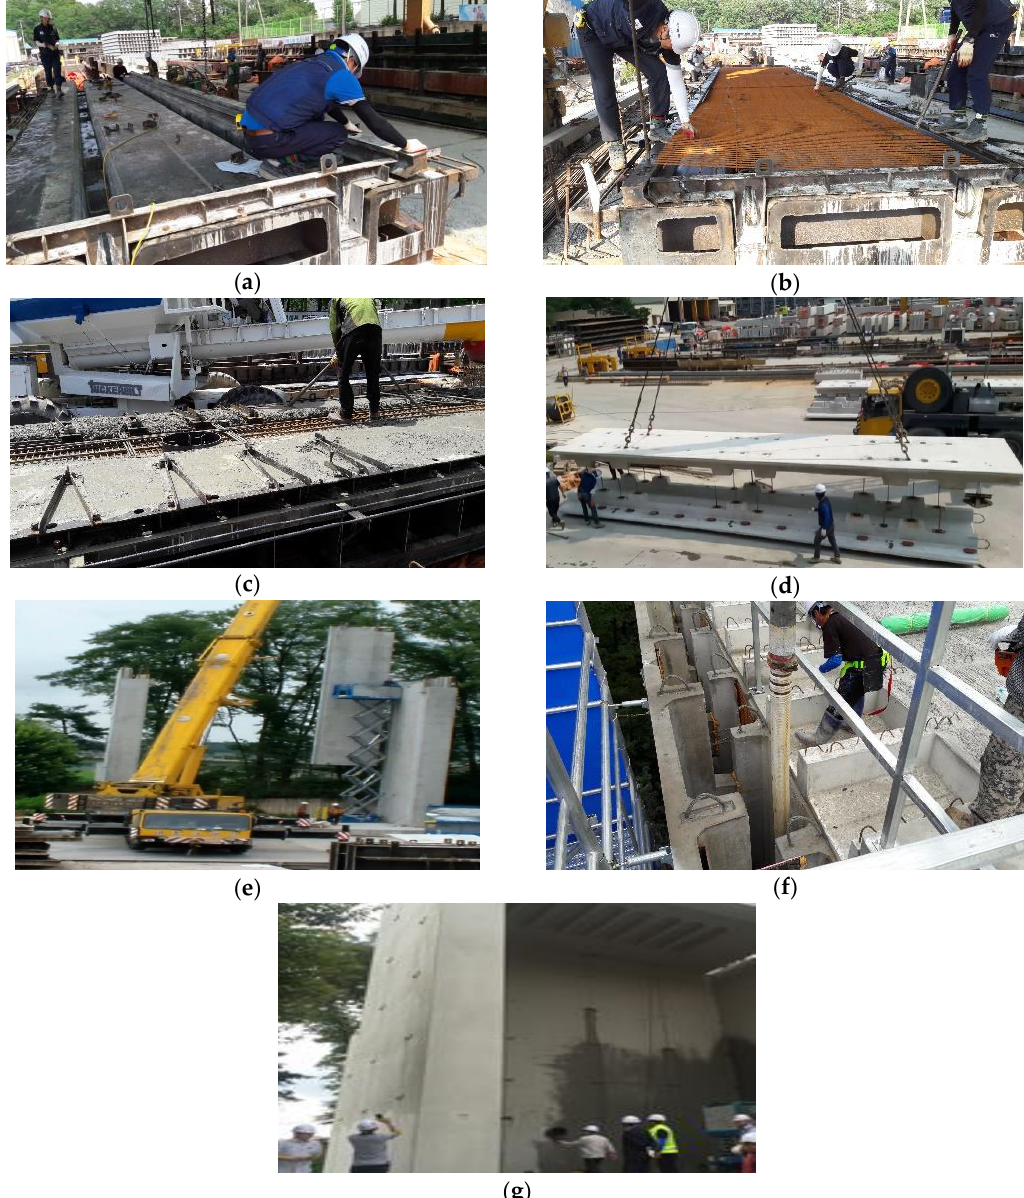
Figure 2. Construction process of a real-scale double composite wall (DCW) system: ( a ) assembling mold; ( b ) placing reinforcements; ( c ) casting precast concrete; ( d ) assembling precast panels; ( e ) installing precast panels; ( f ) casting in-filled concrete; ( g ) after construction.